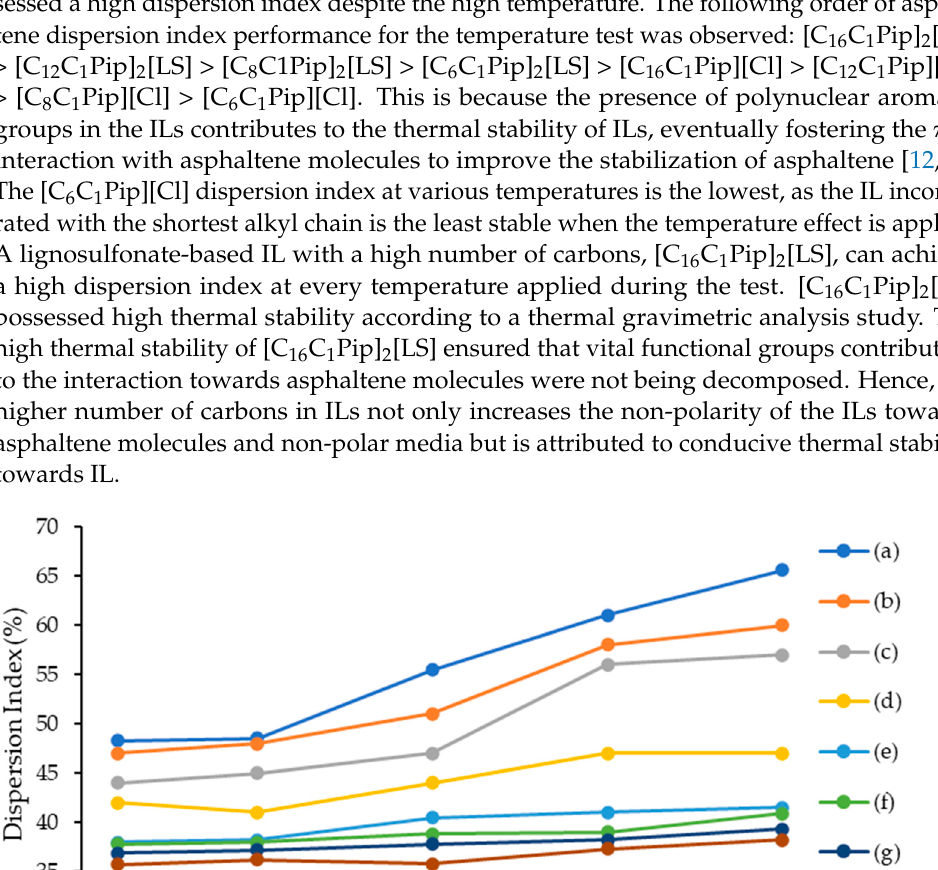
Figure 5. Contact time e ff ect for asphaltene dispersion study. (a) [C 16 C 1 Pip] 2 [LS], (b) [C 12 C 1 Pip] 2 [LS], (c) [C 8 C1Pip] 2 [LS], (d) [C 6 C 1 Pip] 2 [LS] (e) [C 16 C 1 Pip][Cl], (f) [C 12 C 1 Pip][Cl], (g) [C 8 C 1 Pip][Cl], (h) [C 6 C 1 Pip][Cl].